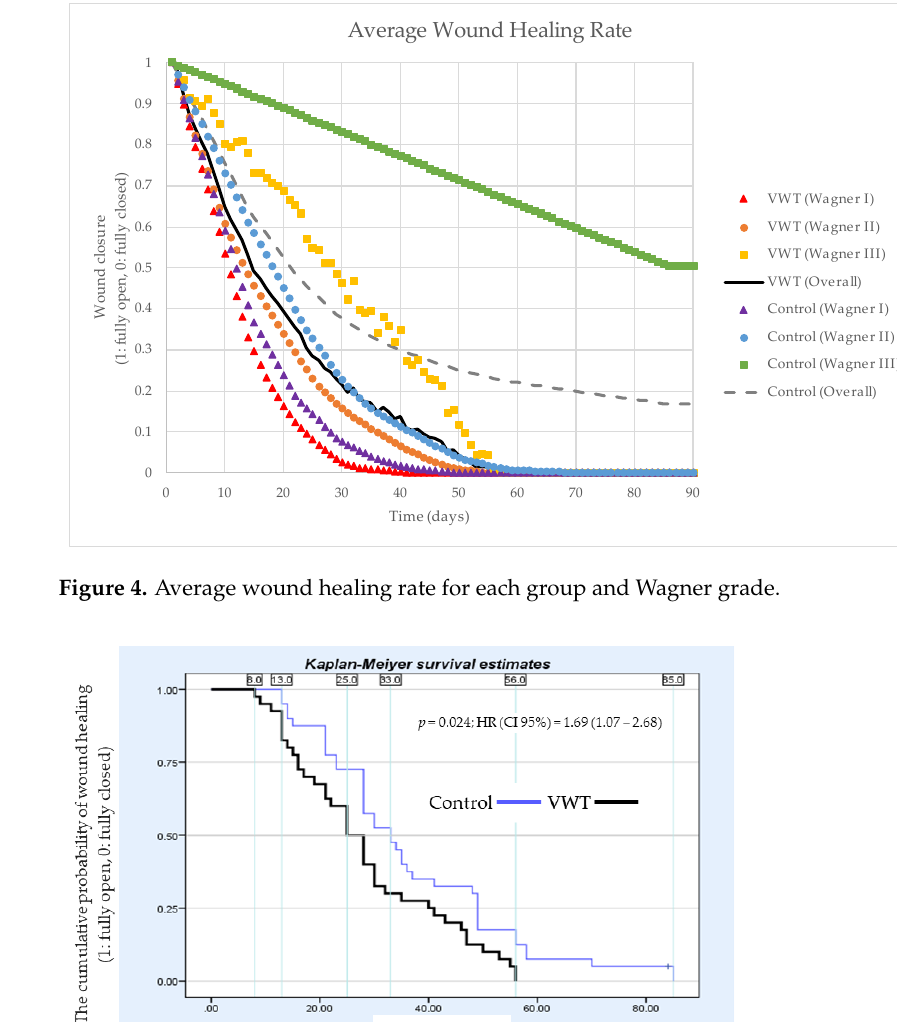
Figure 5. Comparison of the wound healing rate between the intervention and control groups.